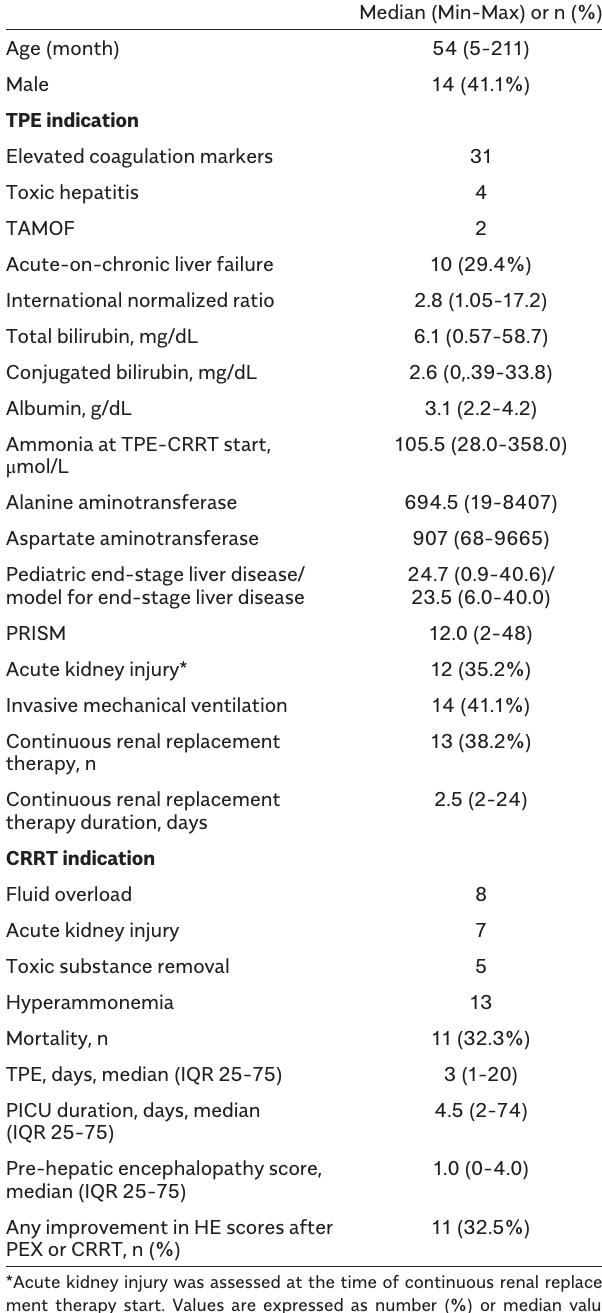
Table 1. Demographics and Baseline, Clinical, and Biological Patient’s